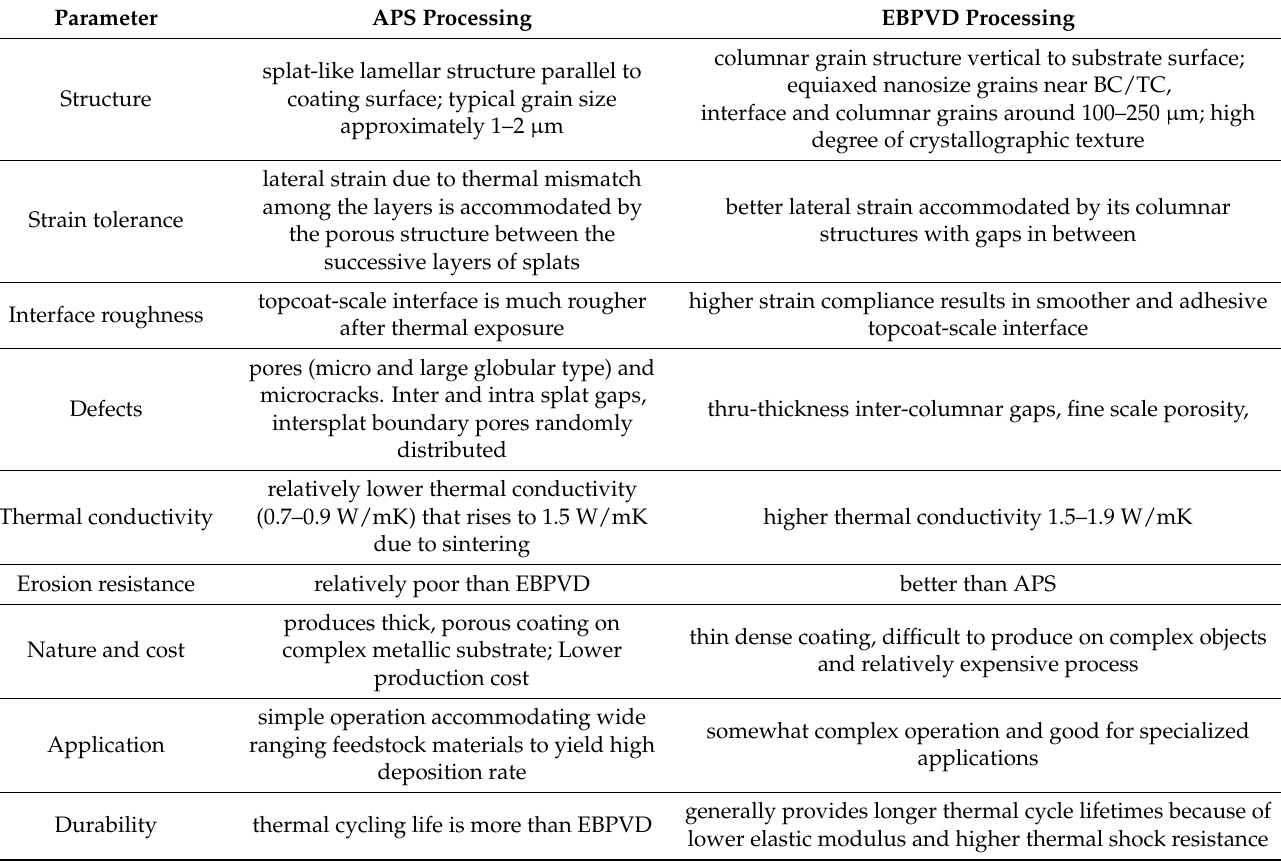
Table 1. Key characteristics of APS- and EBPVD-processed TBC systems